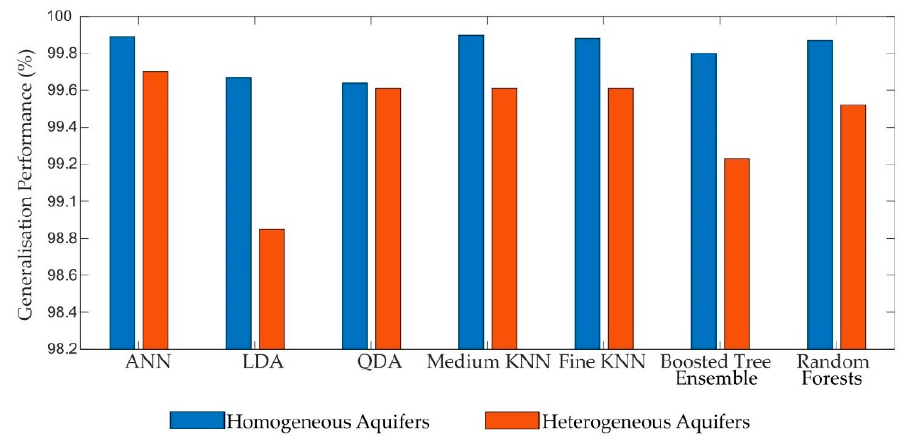
Figure 7. Generalization Performance of seven distinct machine learning techniques (MLT).